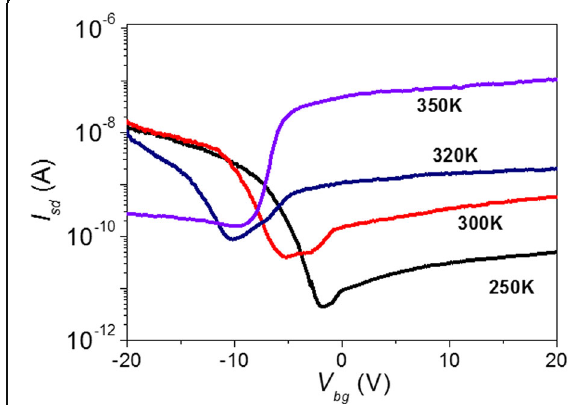
Fig. 5 The transfer characteristics of multi-layered MoTe 2 transistor as a function of temperature in vacuum